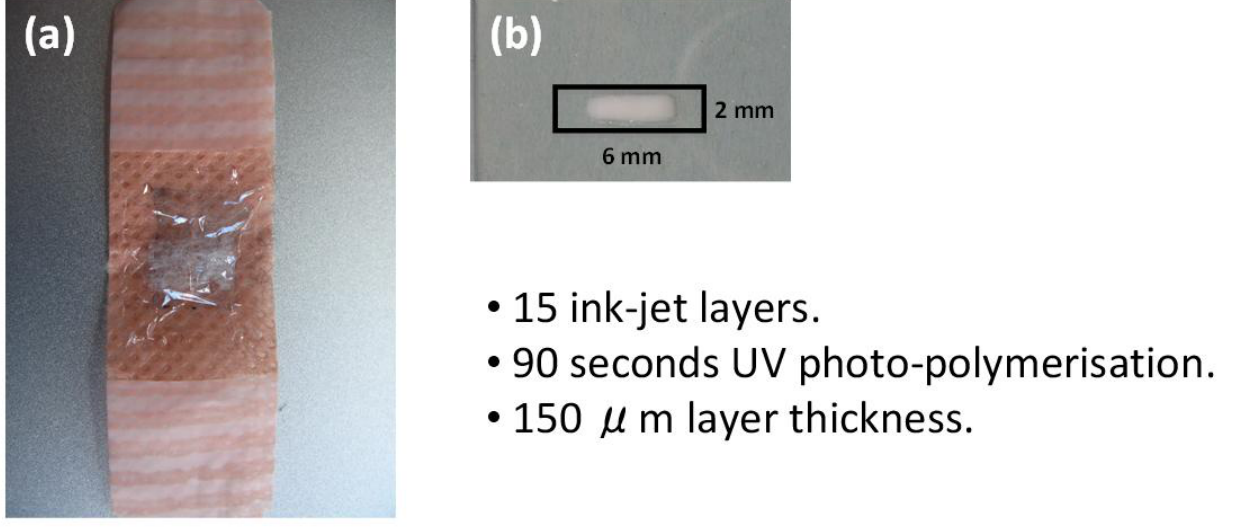
Figure 10. A printable OECT/Ionogel composition incorporated into a widely available fabric (plaster) and the development of printable ionogels. Volumes are in the nL